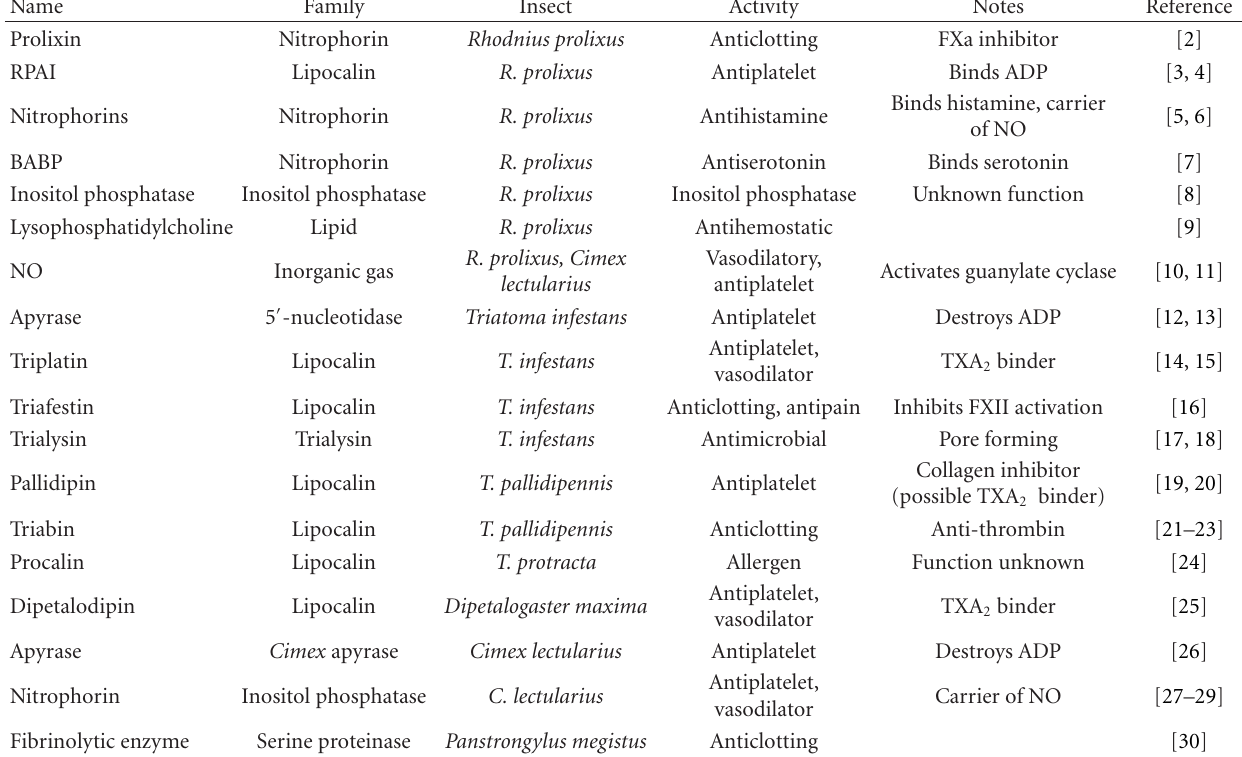
Table 1: Molecularly and functionally characterized salivary components of bloodfeeding Hemiptera.